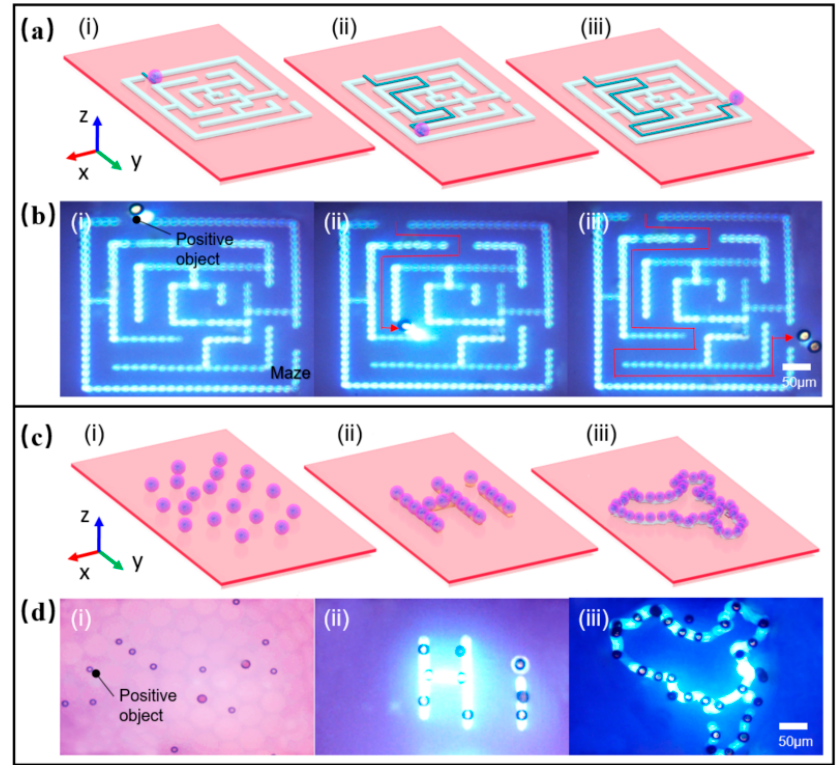
Figure 10. Transporting or patterning the microparticles via OET. ( a ) Schematic of transportation of microparticle through the maze; ( b ) Images of transportation of microparticle through the maze; ( c ) Schematic of patterning microparticle into different patterns; ( d ) Images of patterning microparticle of “Hi” word or map outline of China.